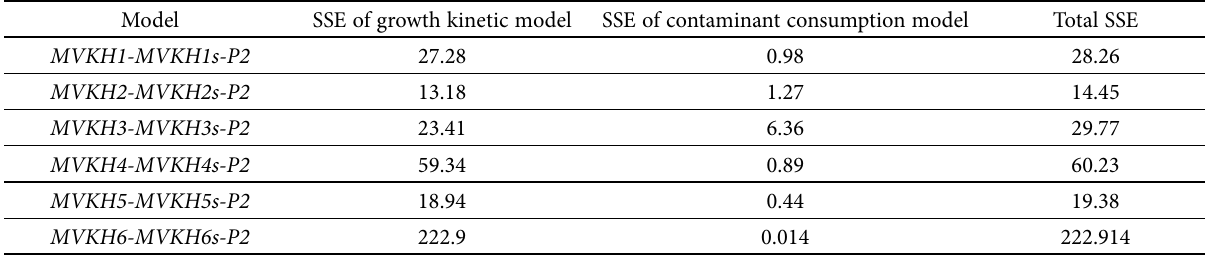
Table 9. The SSE of microbial growth kinetic and contaminant consumption models, as well as total SSE obtained from simulations of the second